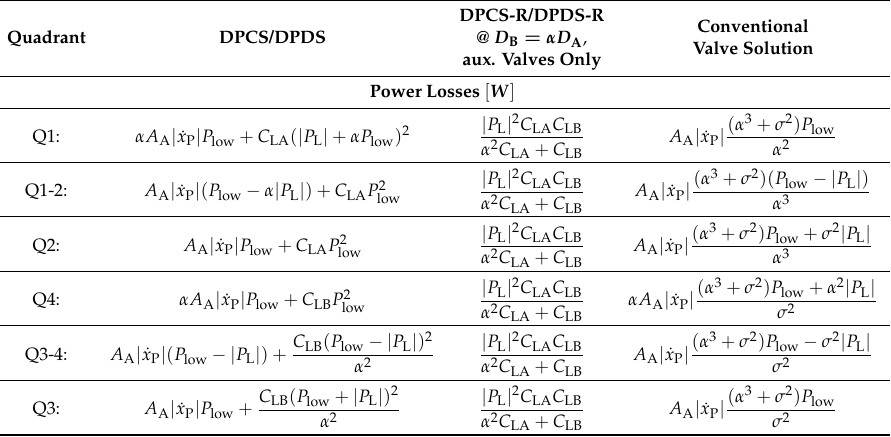
Table 1. Summary of power losses in proposed drive architectures and conventional valve